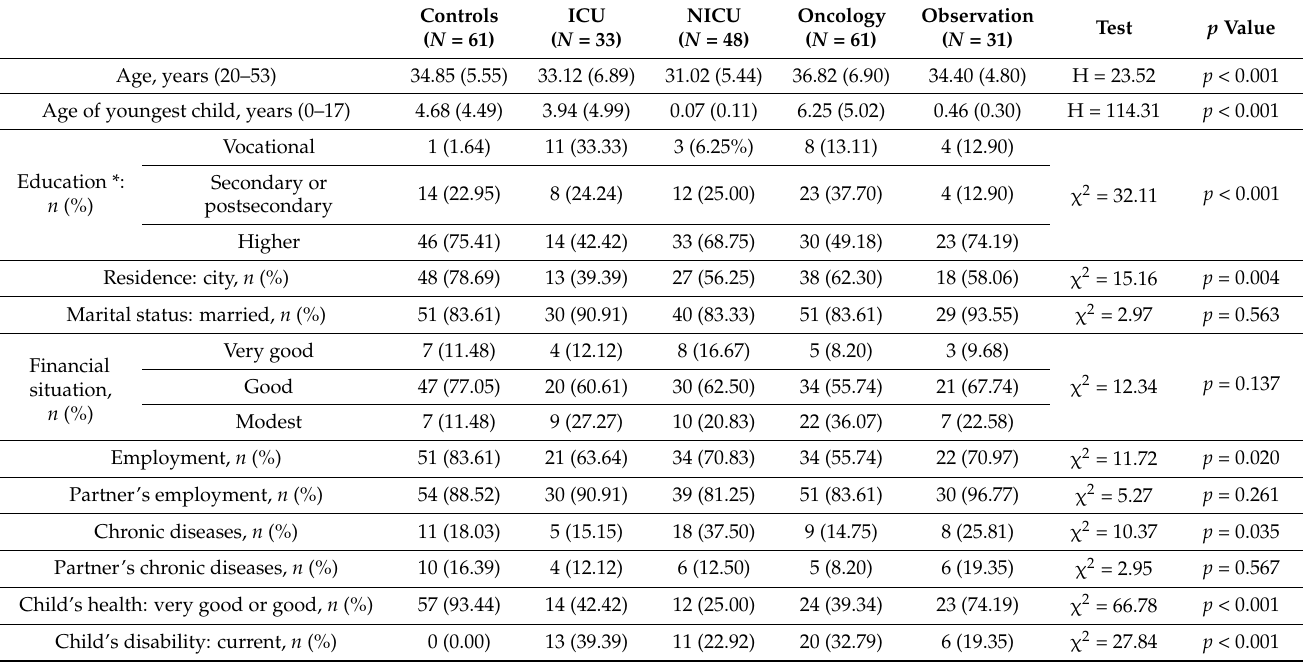
Table 1. The characteristics of the examined